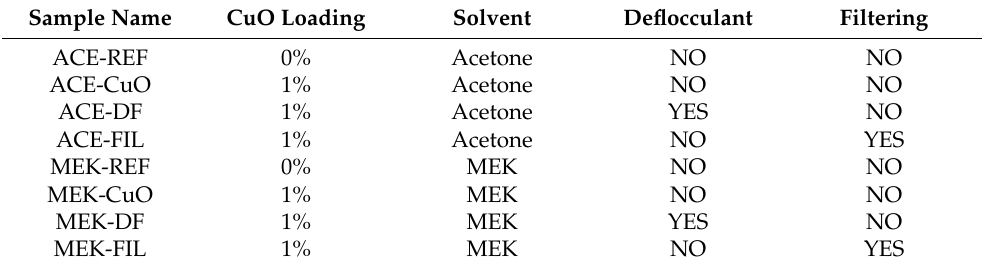
Table 2. Phase 2 samples coated with CuO/PMMA polymer nanocomposite solutions. Prefix ACE corresponds to solutions prepared with acetone as the solvent, while prefix MEK corresponds to solutions prepared with MEK as the solvent. DF denotes the addition of deflocculant and FIL denotes that the solution was